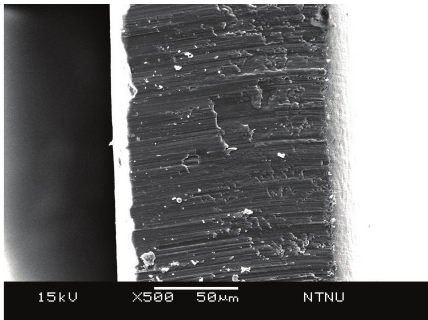
Figure 2: Cross-section observation of annealed titanium